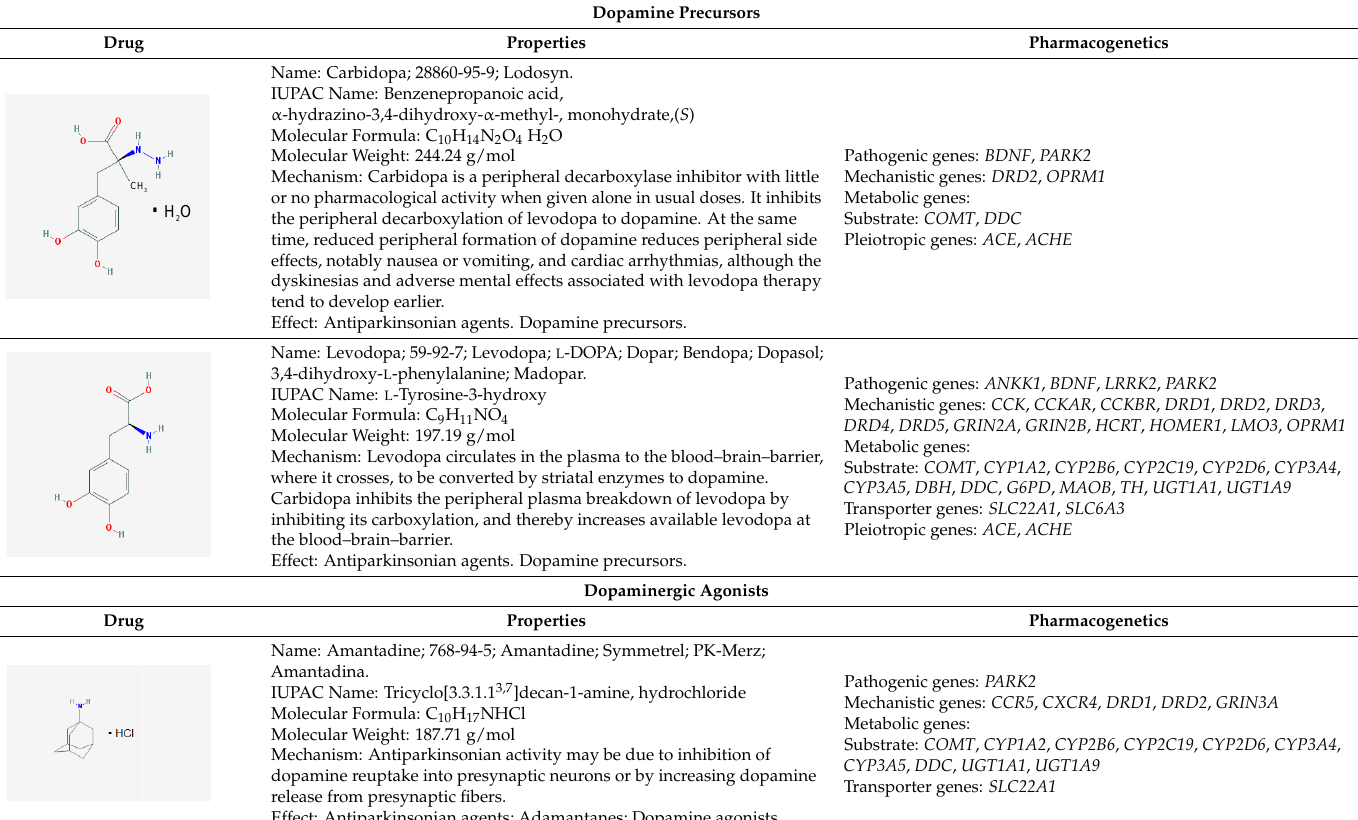
Table 1. Pharmacogenetics of antiparkinsonian